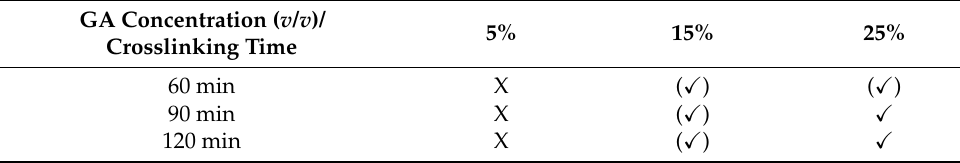
Table 1. Effect of various crosslinking conditions on gelatin nanofiber stability under aqueous conditions. The symbols indicate instable fibers (X), semistable fibers (( (cid:88) )), and fibers that were stable for more than one week ( (cid:88)